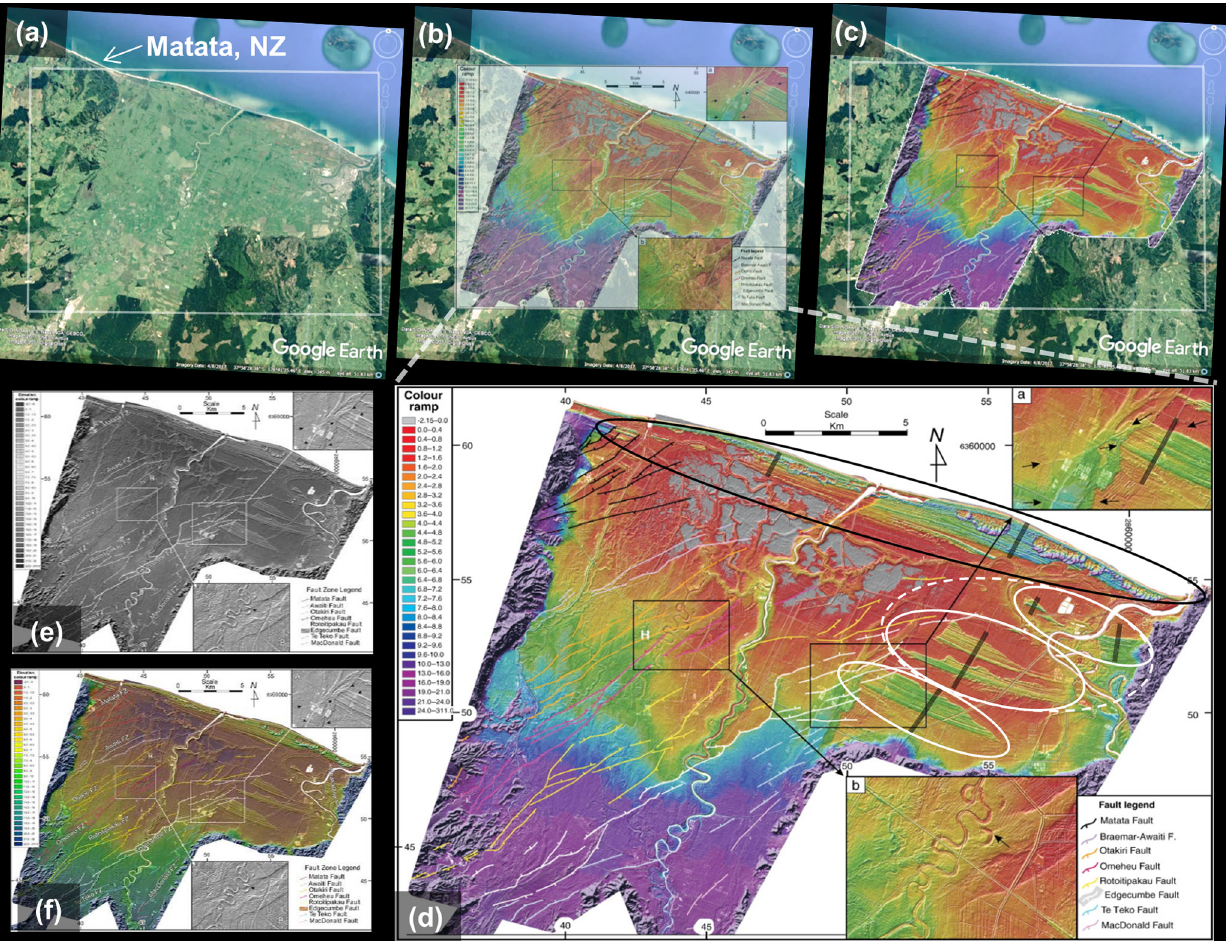
Figure 2. (a–c) A Google Earth image of Rangitaiki Plains, New Zealand, overlain with lidar shows complex infilling of this coastal embayment. (d) The modern coastline displays a prograded barrier island (black oval). Faulting and river dynamics appear to have eroded the central and western portion of older prograded barrier islands preserved in the eastern portion of the embayment (white ovals). Note the difference in the rendering of the lidar data and how the colour scheme chosen can either highlight the barrier structures (b–c) or blend them with the background (e–f) . Lidar modified from Begg and Mouslopoulou